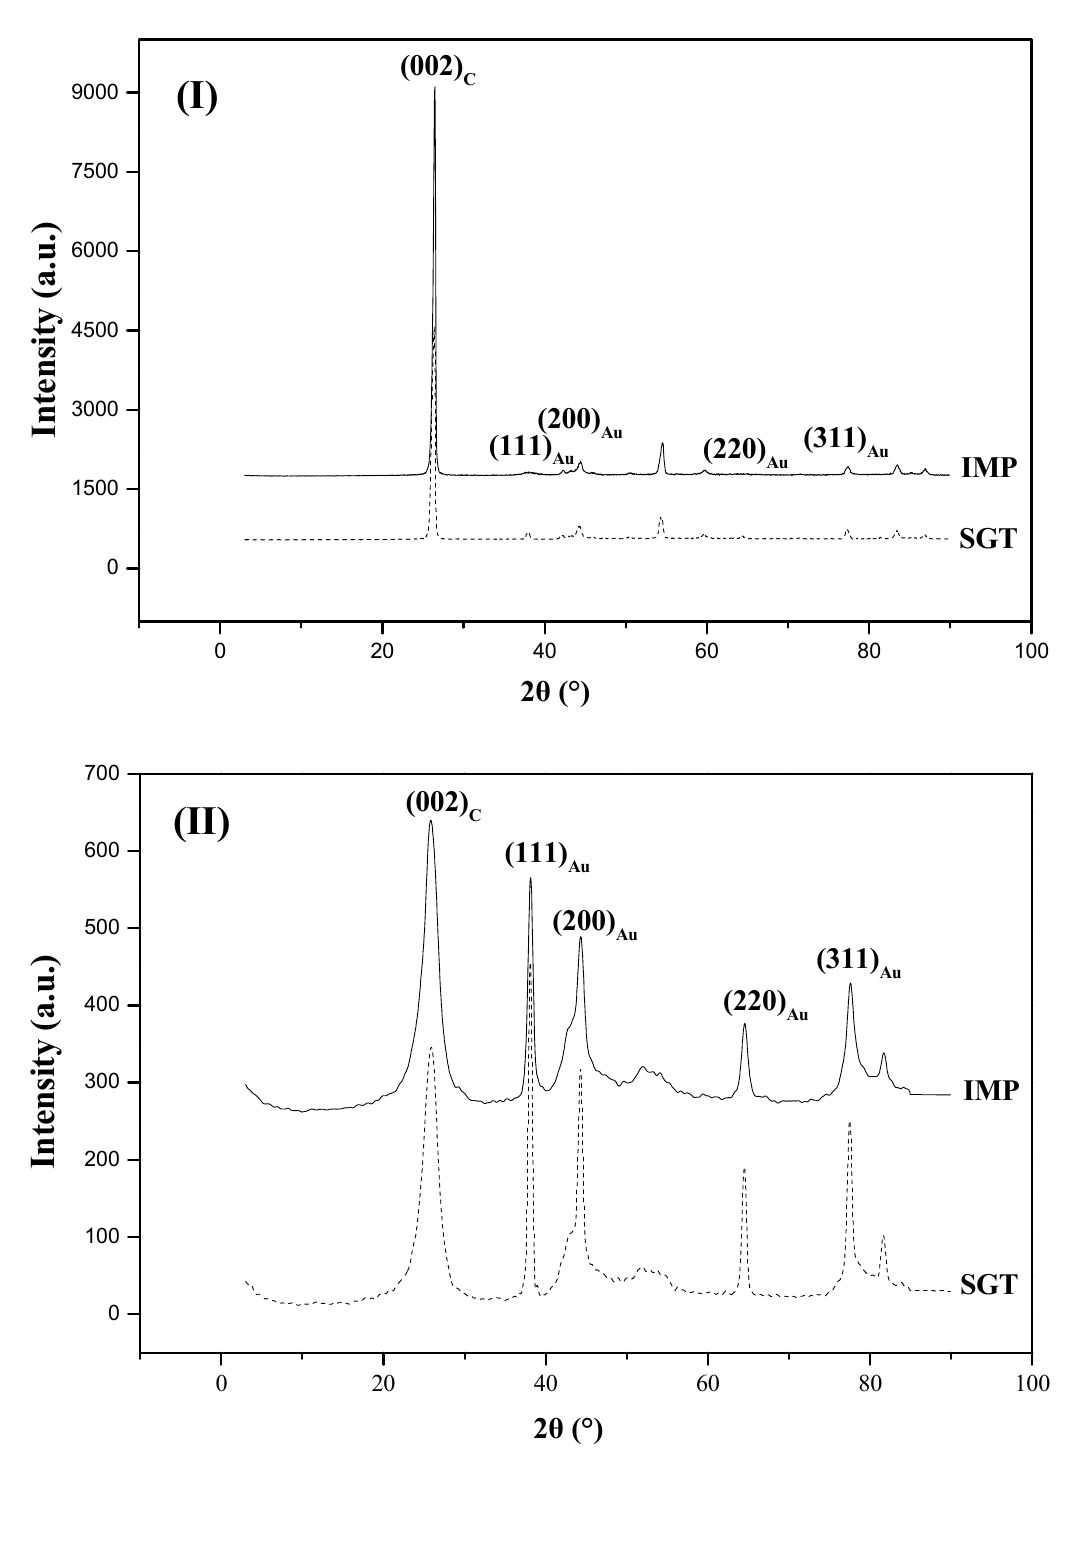
Figure 6. XRD patterns associated to the reduced samples ( I ) Au/G and ( II )